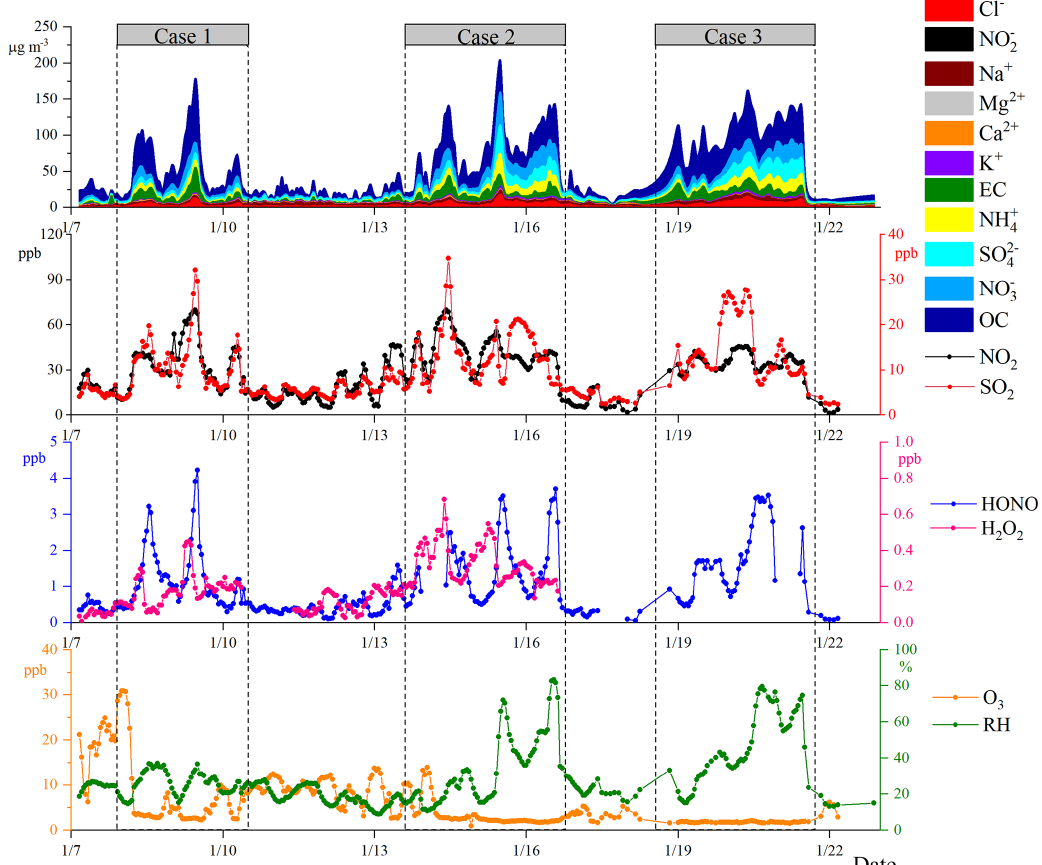
Figure 1. Time series of the species in PM 2 . 5 and typical gaseous pollutants (NO 2 , SO 2 , O 3 , HONO and H 2 O 2 ) as well as atmospheric RH during the sampling